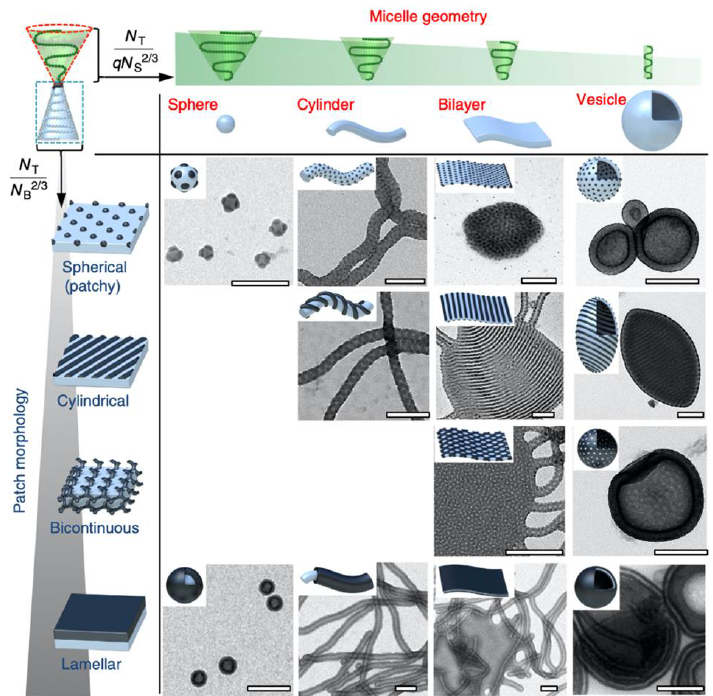
Figure 20. Multicompartment nanostructures from a series of PS- b -PB- b -PT triblock terpolymers. Reproduced with permission of [10]. Copyright 2016 Nature Publishing Group.